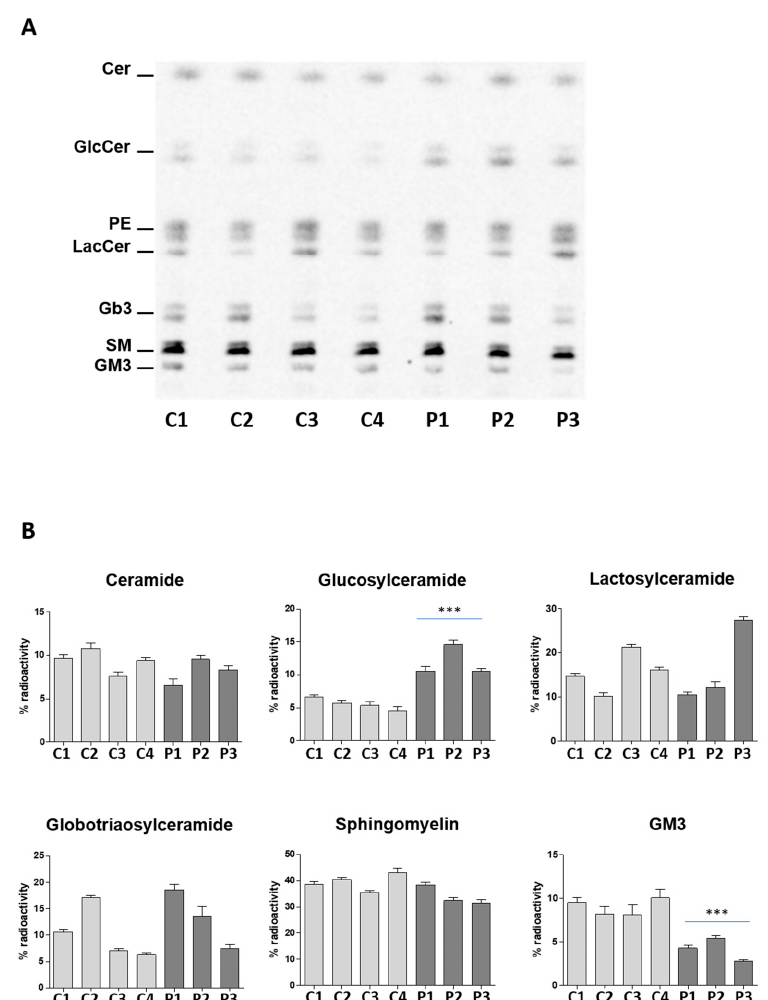
Figure 2. Radioactive sphingolipid pattern of control and patient LCLs. Total lipid extracts were separated by thin layer chromatography using the solvent system Chloroform/Methanol/Water 110:40:6 ( v : v : v ). ( A ) Representative digital autoradiogram obtained by the Beta-Imager T Racer equipment (BioSpace Lab). Same quantities of radioactivity were applied per lane. Ceramide (Cer), glucosylceramide (GlcCer), phosphatidylethanolamine (PE), lactosylceramide (LacCer), globotriaosylceramide (Gb3), sphingomyelin (SM), and ganglioside GM3. ( B ) Distribution of the radioactive sphingolipids associated with the total lipid extract expressed as % of the total radioactivity. Data are expressed as mean ± SD of three independent triplicate experiments (*** p < 0.0003 vs. controls).